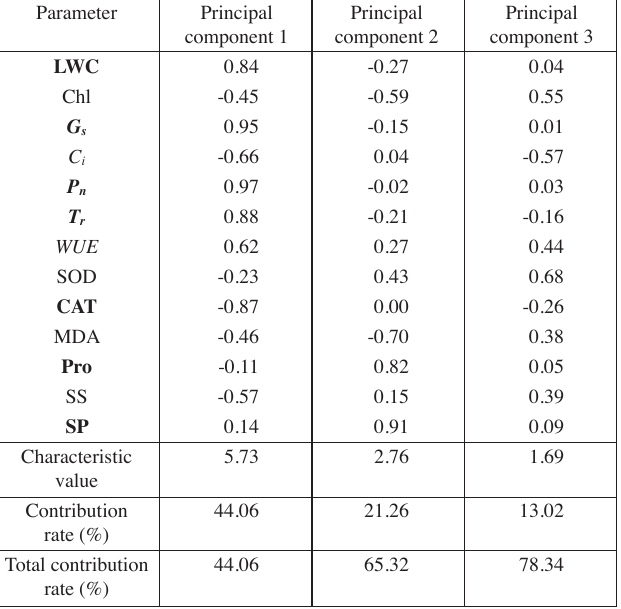
Tab. 4: Principal component analysis (PCA) results of thirteen parameters on seedlings treated by drought